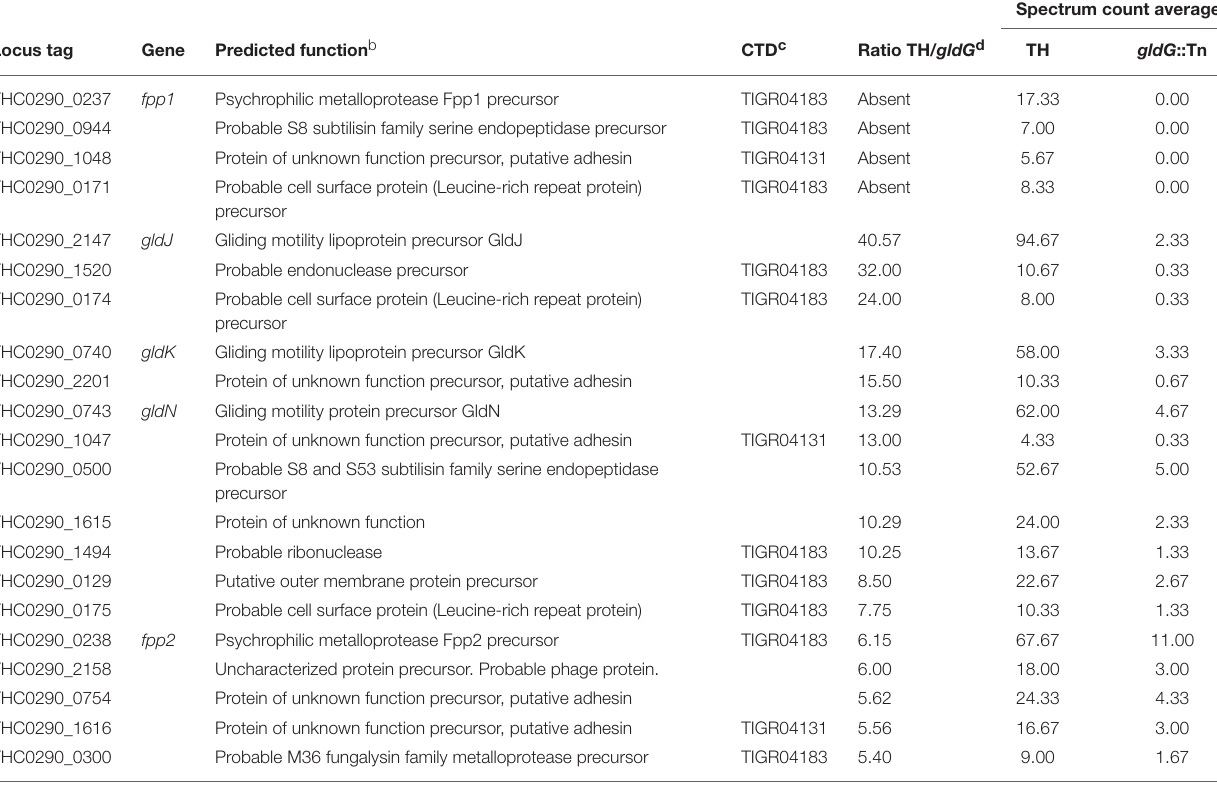
Spectrum count averages e